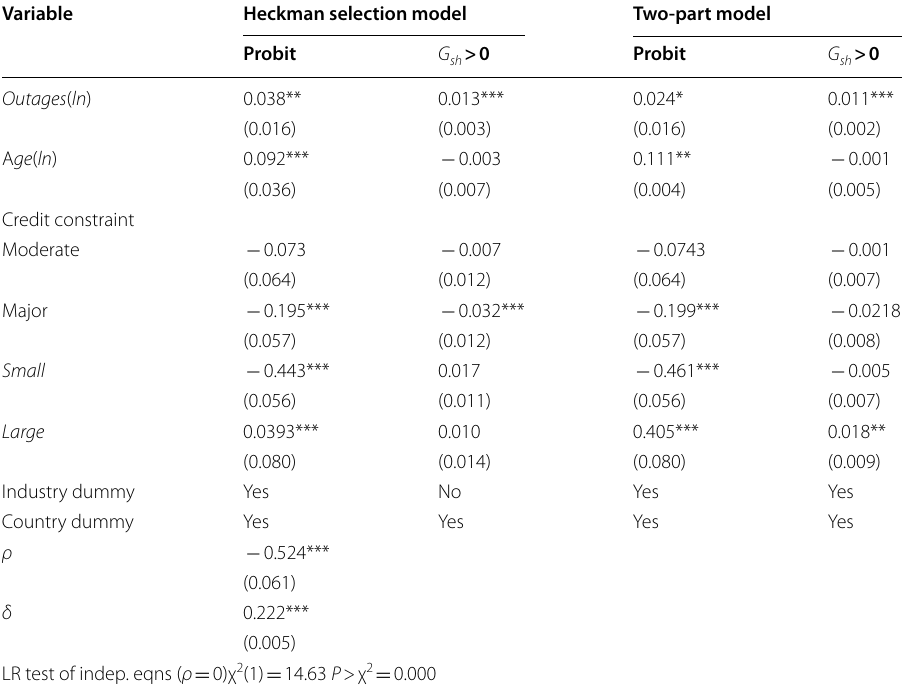
Table 6 Credit constraint and